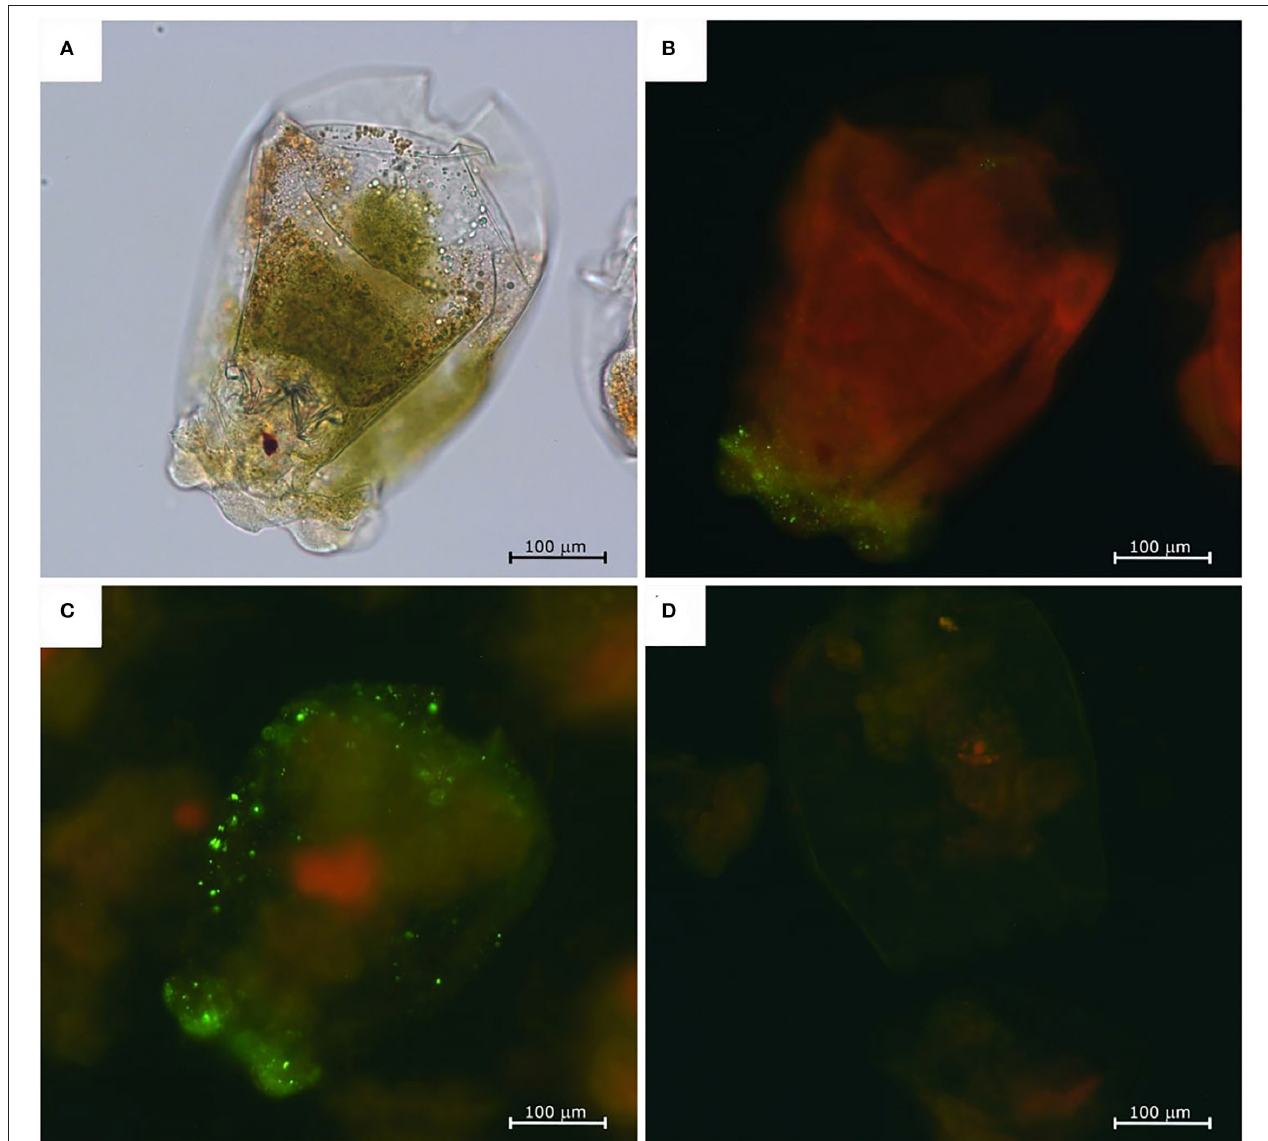
FIGURE 2 | Nervous necrosis virus-exposed rotifers immunofluorescence assay. Challenged rotifer at 6 hpc, normal appearance under a light microscope (A) , and fluorescent microscope (B) . Fluorescence staining is visible mainly in the crown area. Challenged rotifer at 24 hpc (C) , and fluorescence localized on the crown and in the pseudocoelom. Negative control at 24h (D)